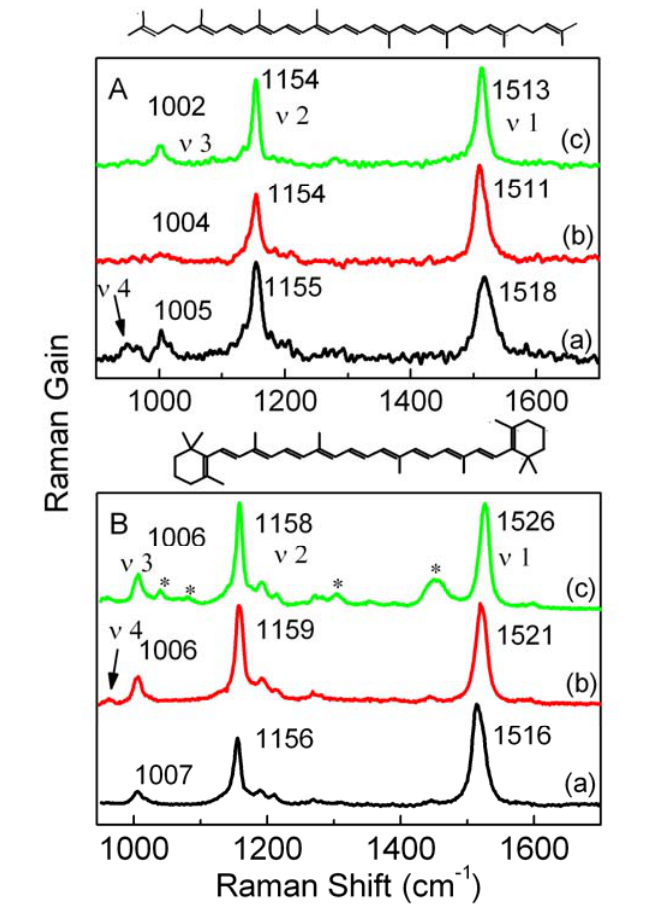
Figure 1. Raman spectra of lycopene (A) and β -carotene (B) in the solid state (a), CS (analytical grade) (b) and n -hexane (c) under ambient conditions. Asterisks in panel B(c) denote the Raman bands from n